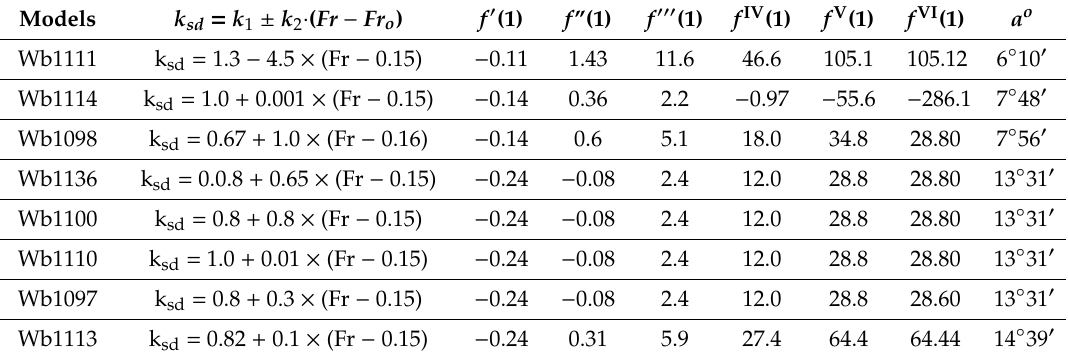
Table 4. Derivatives of the surface equations of the ship hull of Weinblum’s models. Models